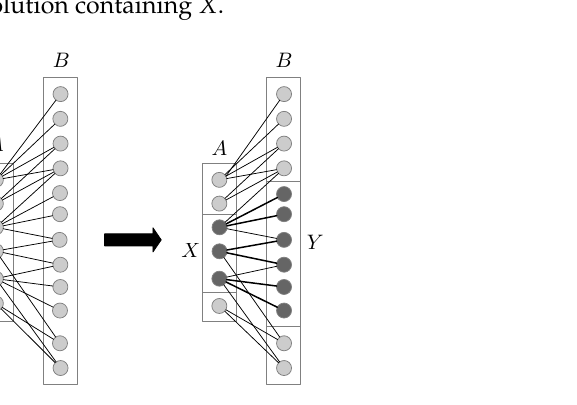
Figure 1. An illustration of Lemma 3 with q =